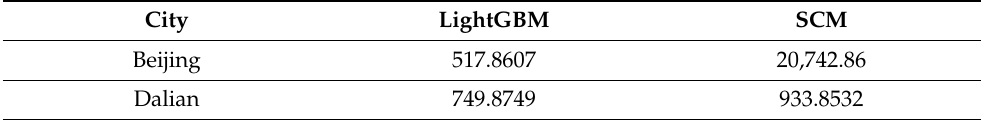
Table 3. Square root of the prediction error,